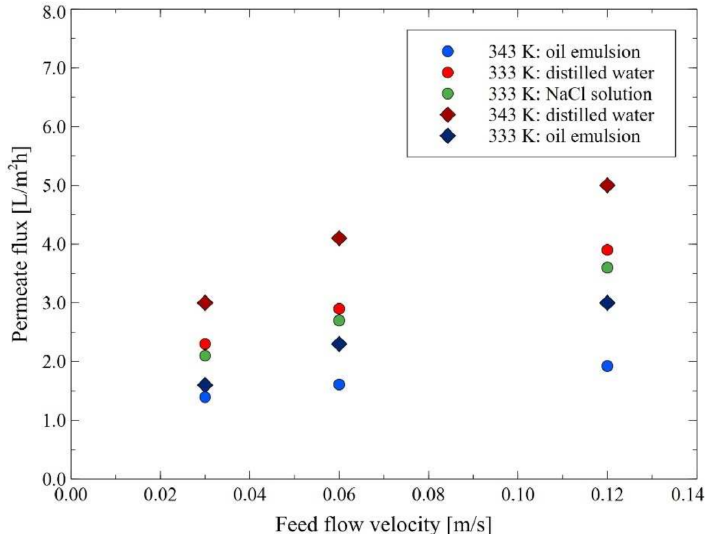
Figure 5. The impact of the feed flow velocity on the permeate flux. Feed: distilled water (T F = 333 K and 343 K), NaCl solution (50 g/L) (333 K), oil emulsion (333 K and 343 K). Module